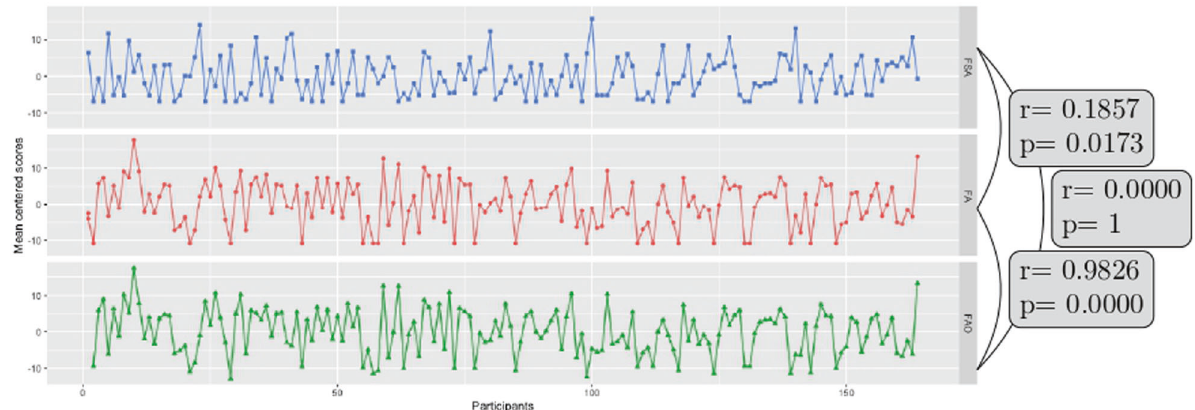
Fig. 3 Psychometric scores across participants before and after othogonalization. FSA: fear somatic arousal scores, FA: fear affect scores before orthogonalization, FAO: fear affect scores after orthogonalization. The correlation values between difference scores are also